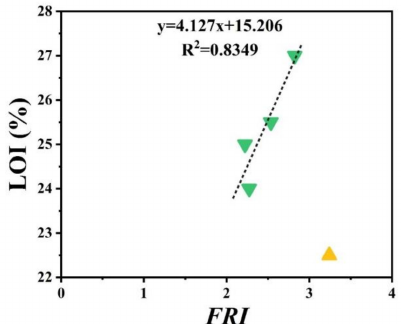
Figure 12. FRI values versus UL-94 test results. Symbols are indicative of di ff erent types of bio-based flame retardant (FR) used. The vertical intervals in each category, i.e., V-0, V-1, V-2, and NR, are schematically representative of the amount of additive used. For example, two data distinguished by di ff erent symbols having the same or very close FRI values (horizontal quantity) in a given category (e.g., V-1) may have di ff erent vertical quantities, e.g., both reveal V-1 behavior in UL-94 test, but the upper contains more FR in PP.